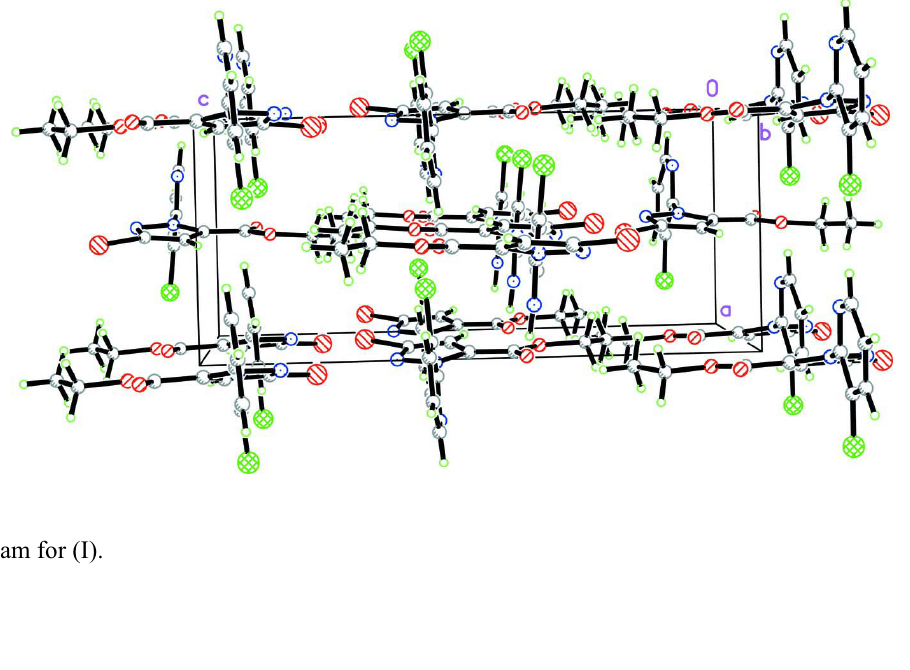
Figure 2 A packing diagram for